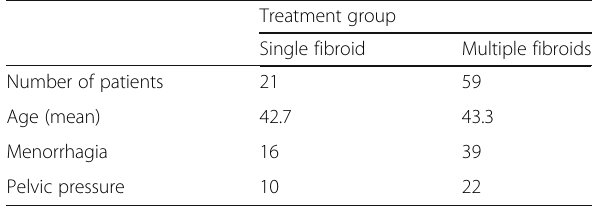
Table 2 Total uterine volume reduction percentage Uterine volume